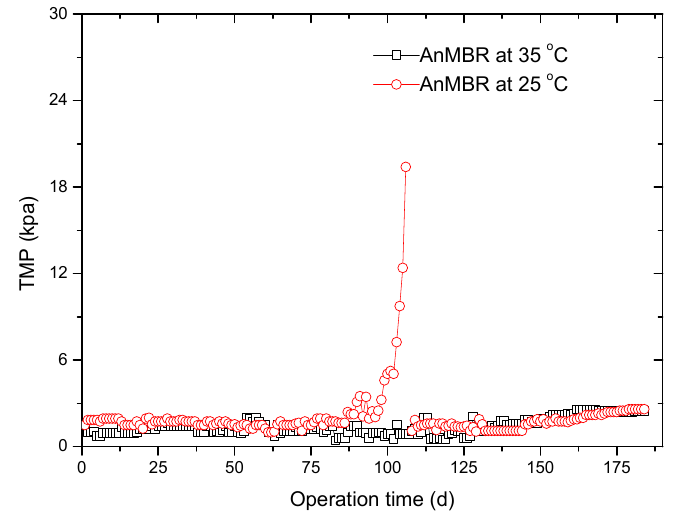
Figure 1. The variations in transmembrane pressure (TMP) throughout the experimental